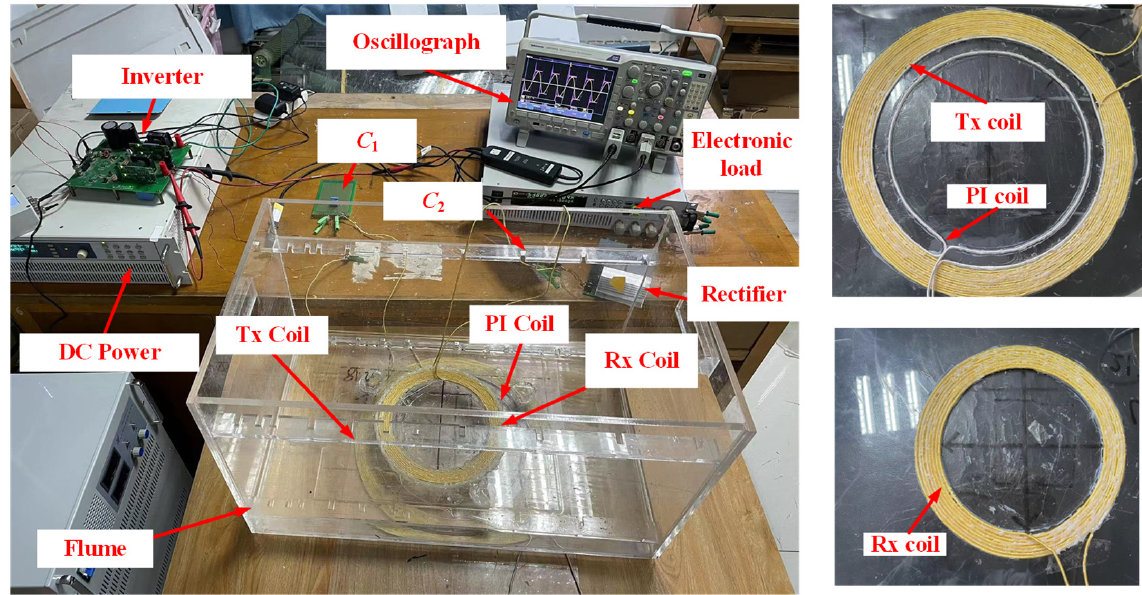
Figure 15. Experimental platform.